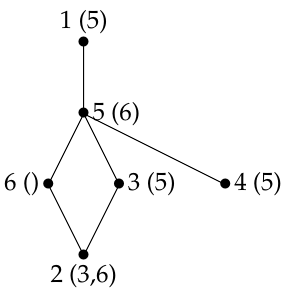
Figure 5. With LexDFS, the minimal separators included in N ( α ( 1 )) are not totally ordered by inclusion.